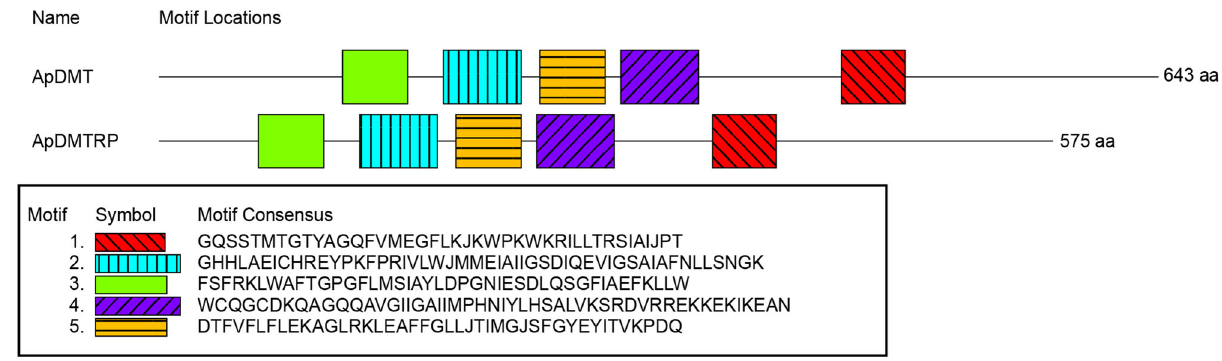
Fig. 2 Conserved motif locations of the crown-of-thorns star fi sh (COTS), Acanthaster planci , divalent metal transporter (ApDMT) and DMT-related protein (ApDMTRP). Conserved domains were identi fi ed using the MEME web server. Colored boxes indicate motifs. Black lines indicate whole proteins and numbers on the right side indicate the length of the encoded amino acid sequence of each gene.